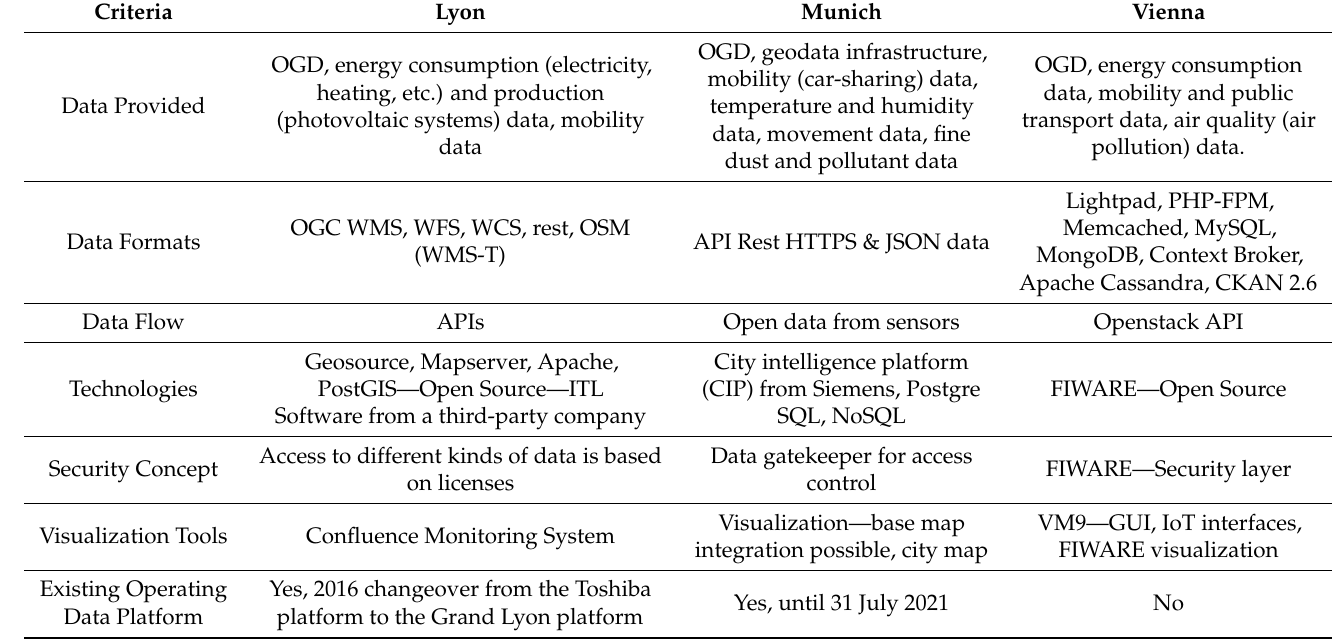
Table 1. A descriptive comparison of digital management platform (DMP) characteristics in each lighthouse city (LHC) [11].